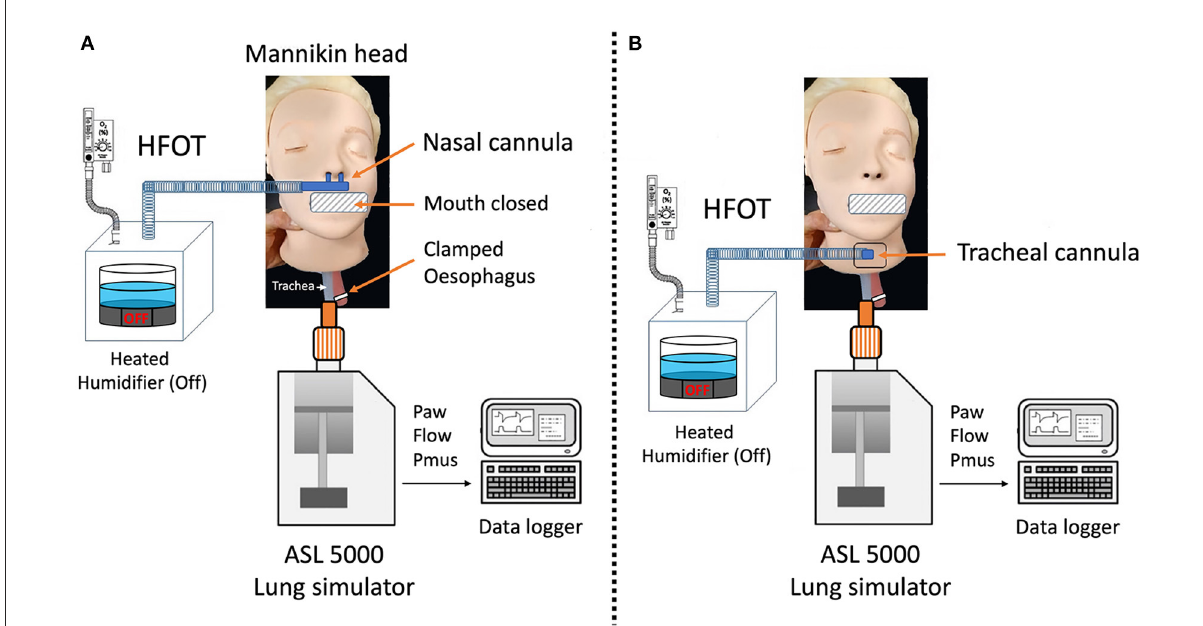
FIGURE1 Bench model. High flow oxygen therapy (HFOT) devices were connected to the head of a manikin designed for cardiopulmonary resuscitation training through either a nasal cannula (A) or a tracheostomy cannula (B) directly inserted into a dedicated hole available in the neck of the manikin head. The mouth was kept closed and the esophagus was clamped. The trachea of the manikin was connected to a lung simulator (ASL5000, Ingmar Medical), set at 40 ml/cmH 2 O compliance, 10 cmH 2 O/L/s resistance, and sinusoidal inspiratory